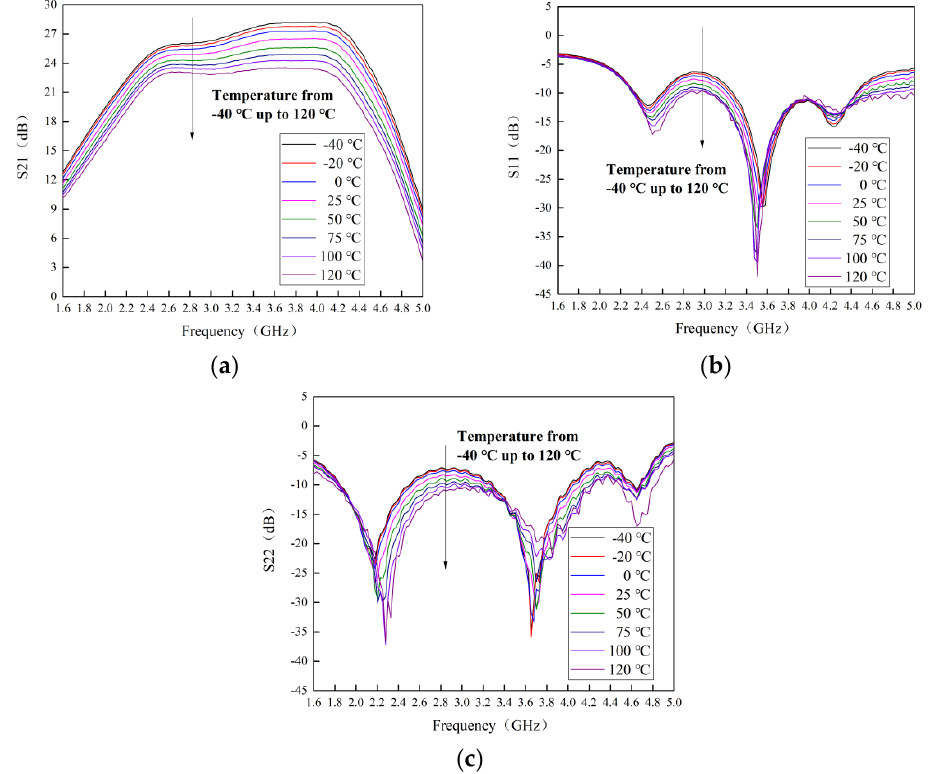
Figure 10. Measured curves of S-parameters at different temperatures: ( a ) S21; ( b ) S11; ( c ) S22.